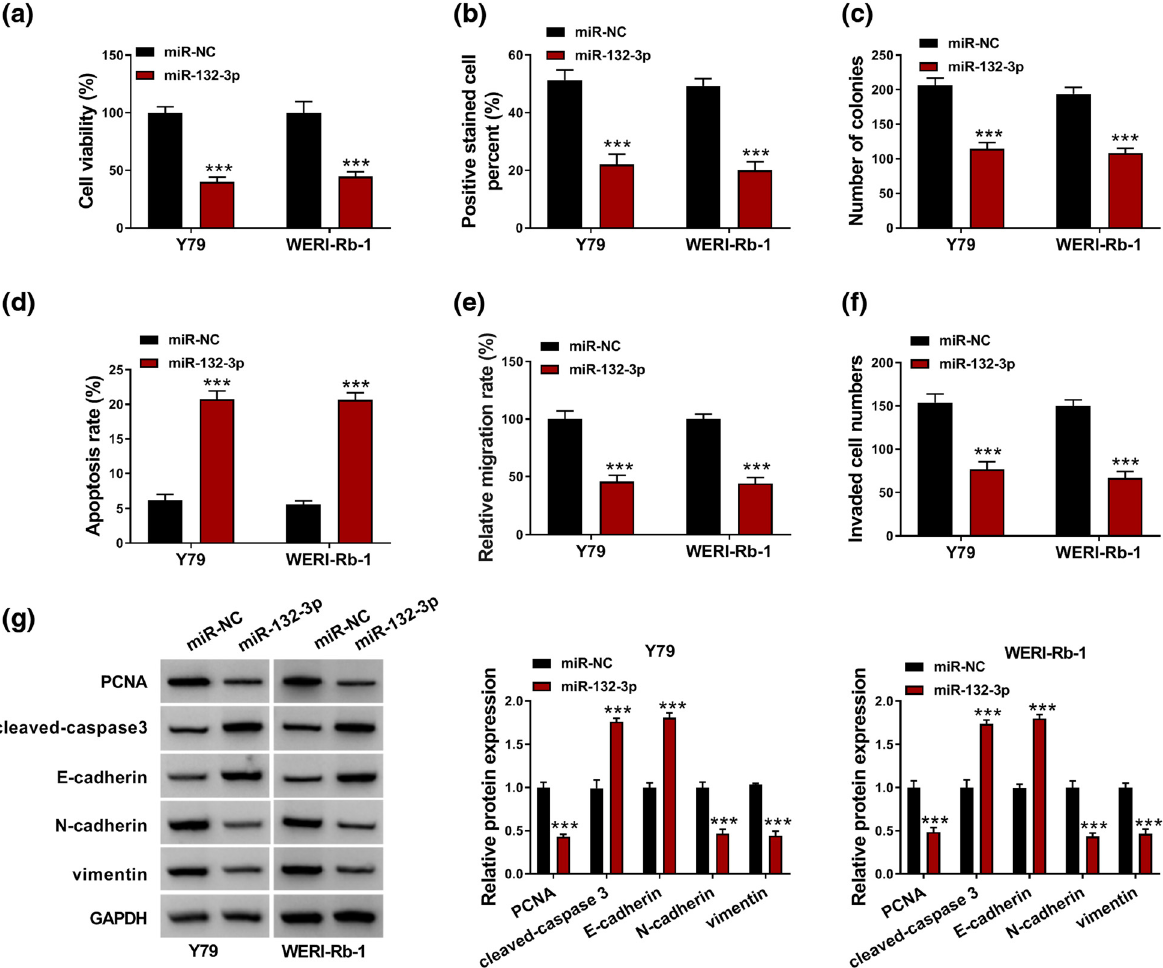
Figure 4: miR - 132 - 3p overexpression inhibited RB cell progression. Y79 and WERI - Rb - 1 cells were transfected with miR - NC or miR - 132 - 3p. ( a – c ) The viability, proliferation and colony formation of Y79 and WERI - Rb - 1 cells were evaluated by CCK - 8 assay, EDU assay and